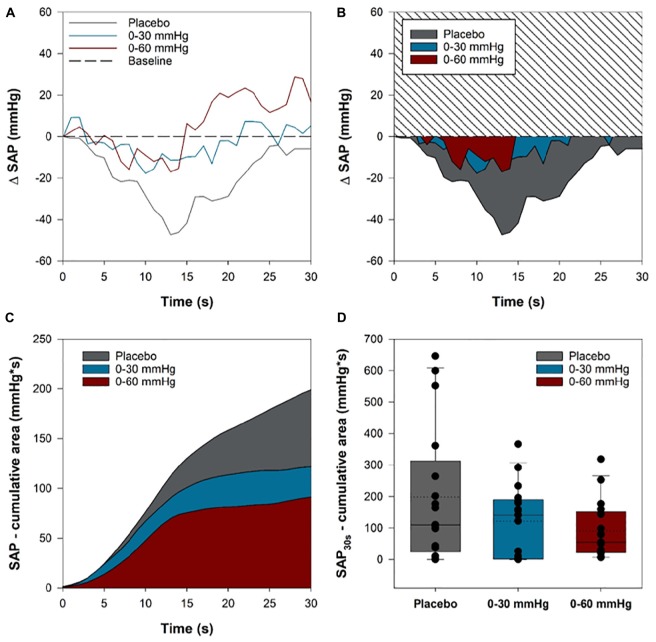
Systolic arterial pressure (SAP) reduction in the initial 30 s of head-up tilt. For each participant, the area of the SAP curve that dipped below baseline values throughout the first 30 s of HUT was integrated for each condition. The area under the curve of the SAP dip for was summed for each participant in each condition. (A) A sample trace from one participant showing the SAP time course in the first 30 s of tilt in the three conditions. (B) The integrated area between the baseline and SAP curves in each of the three conditions for the same sample participant. (C) The cumulative summed area for all participants in each of the three compression conditions throughout the first 30 s of tilt. (D) Boxplots comparing the cumulative summed area between the baseline and SAP curves for each participant in the three conditions. Solid lines show the sample median, while dashed lines depict the sample mean.